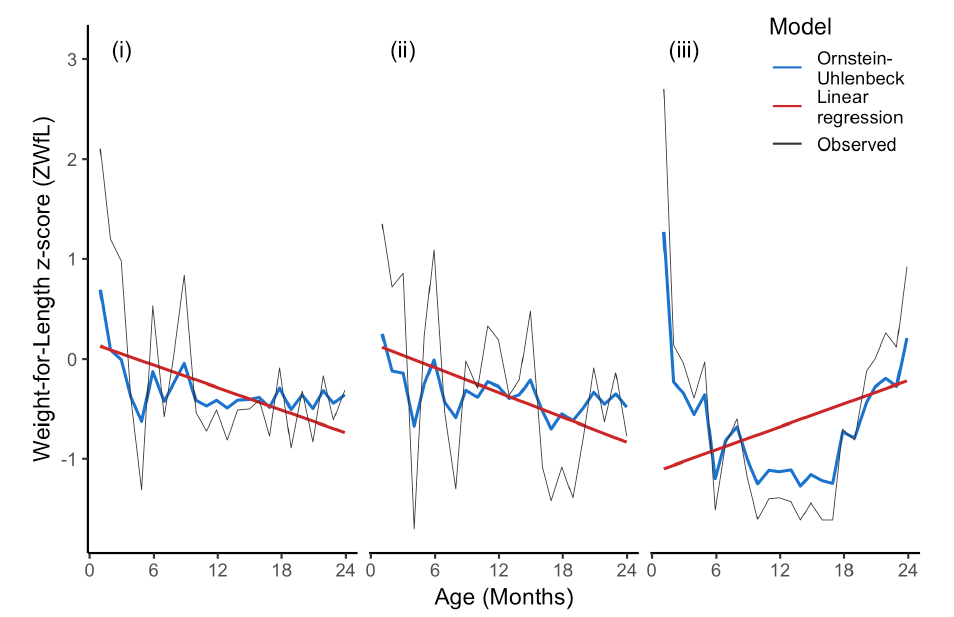
Figure 2. Comparison of stochastic differential equation (SDE assuming an Ornstein-Uhlenbeck process) model and linear regression model for three children from Haydom, where both models have three parameters. The difference between a curve fitting approach (fit globally) and time series approach (based on modelling the change over time) is clearly